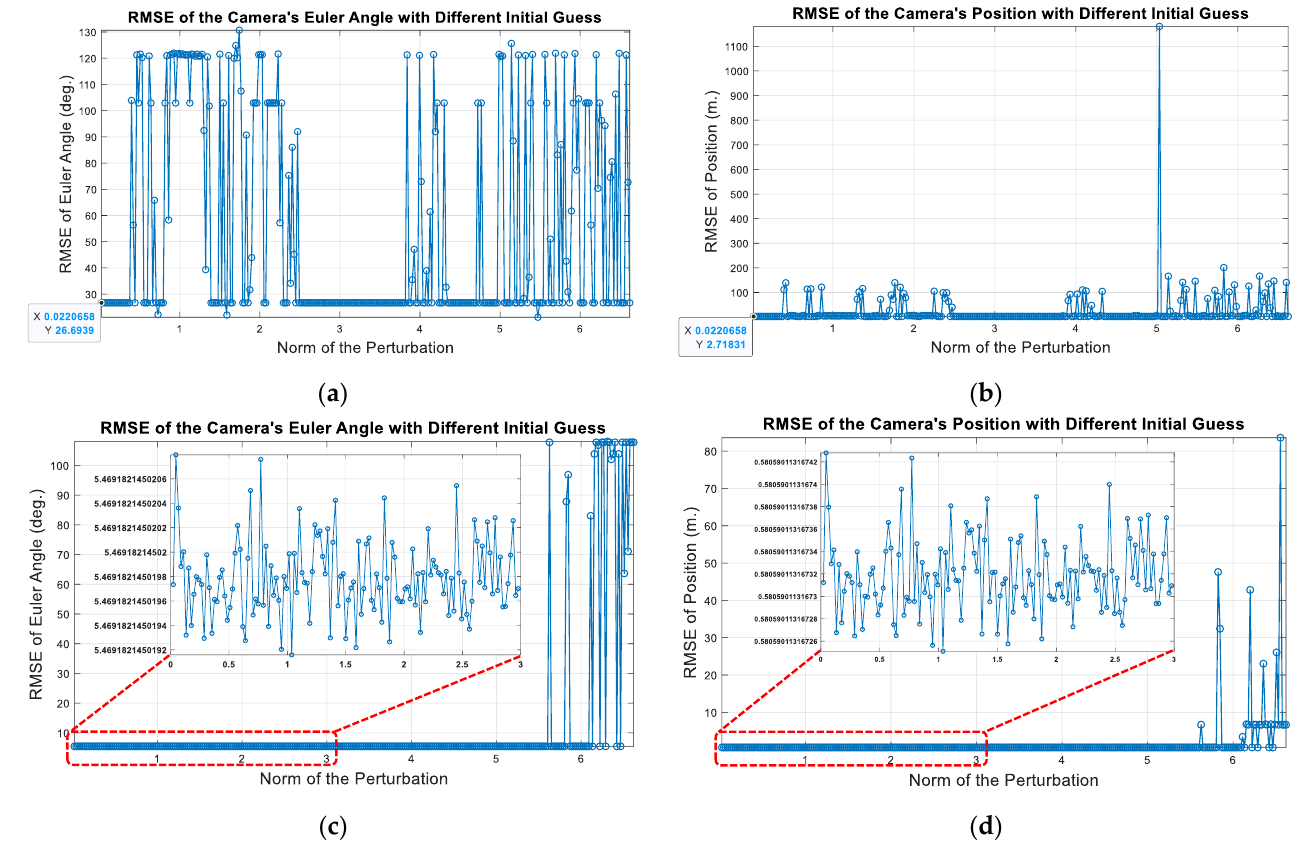
Figure 9. Optimization results of motion-only BA according to different initial guesses: ( a ) RMSE of Euler angle (without using Huber); ( b ) RMSE of position (without using Huber); ( c ) RMSE of Euler angle (with using Huber); ( d ) RMSE of position (with using Huber).